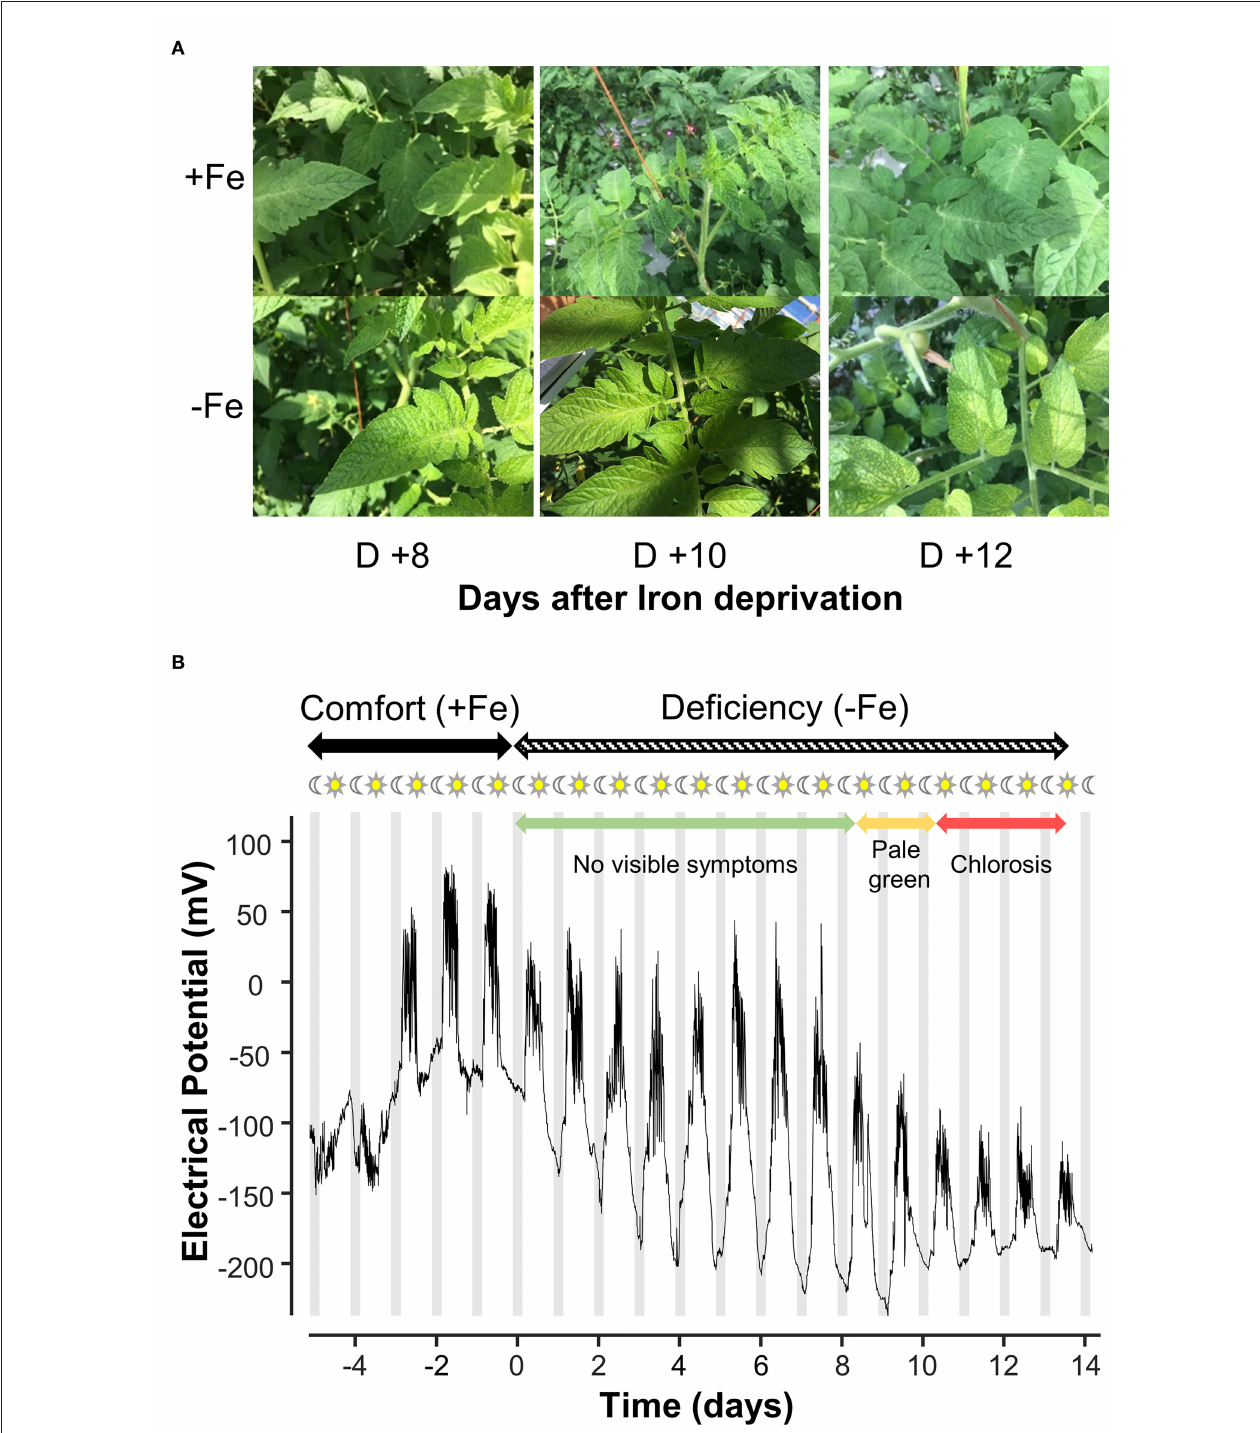
FIGURE 1 | (A) Hydroponic tomato plants in soilless culture grown in commercial greenhouse were submitted to different fertigation regimens: optimal nutrient condition ( + Fe) or without iron during 14 days (–Fe). First symptoms of iron deficiency appeared 8 days (D + 8) after deprivation with pale green leaves on top. Plants exhibit typical interveinal chlorosis after 10 days (D + 10) becoming more pronounced after 12 days (D + 12). (B) Representative long-term recordings of electric potential (EP) used as training dataset for modeling. Plants were submitted to optimal nutrient condition (comfort, + Fe) followed by iron deprivation (deficiency, –Fe) in fertigation. Colored arrows represent different stage of symptoms on young leaves from non-visible ( green ) to pale green ( yellow ) then chlorosis ( red ).